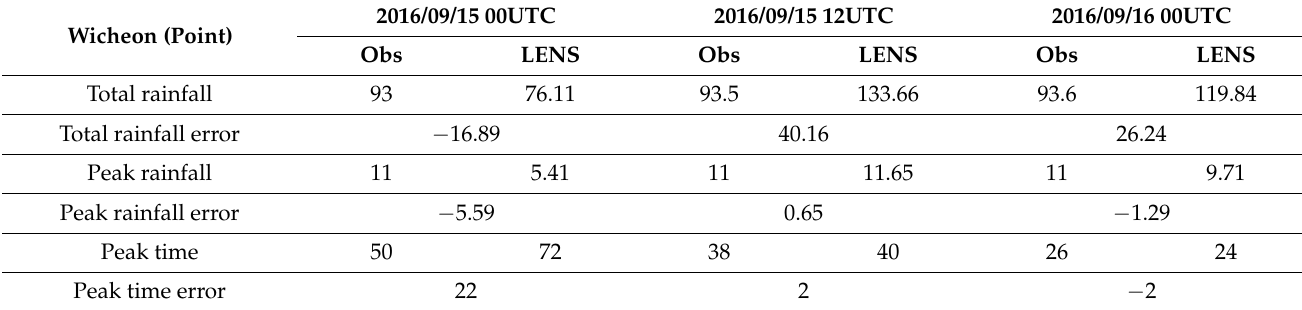
Table 4. LENS point data from 2016/09/15 00UTC to 2016/09/16 00UTC.